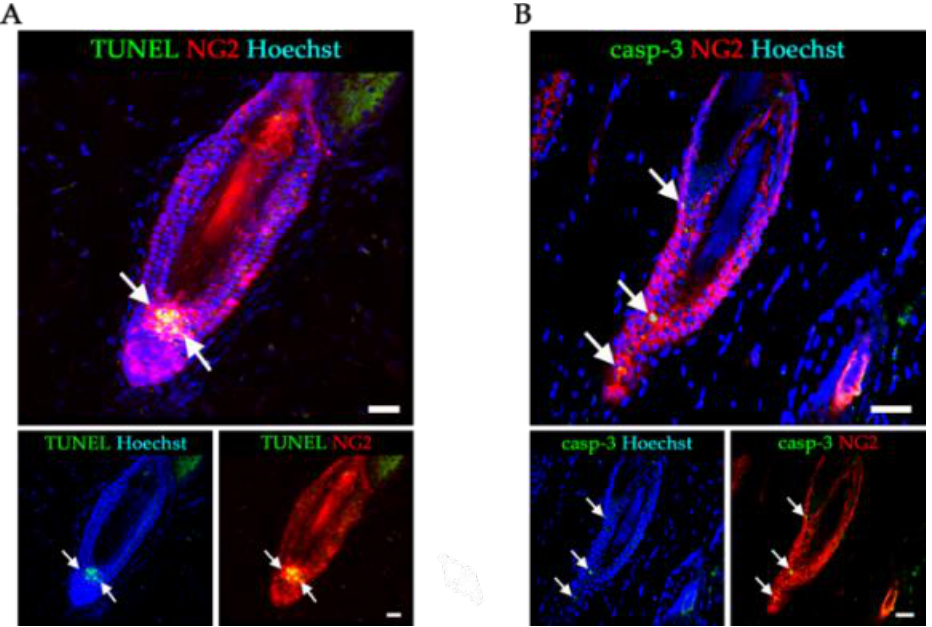
Figure 2. TUNEL and activated caspase 3 staining in NG2 + HFSCs following application of GCV to the skin of Tg rats. ( A ) Skin sections stained with TUNEL (green) and NG2 (red) antibodies. ( B ) Skin sections stained with activated caspase-3 (casp-3) (green) and NG2 (red) antibodies. Arrows in ( A ) and ( B ) indicate HFSCs co-expressing NG2 and markers of apoptotic cell death. Scale bars, 50 μm.